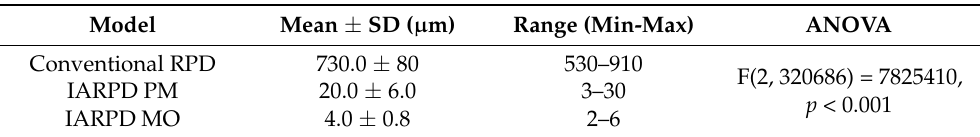
Table 4. Mean values and range of the magnitude of displacement of each model. Statistical analysis with one-way ANOVA. SD- standard deviation; min- minimum; max- maximum. Model